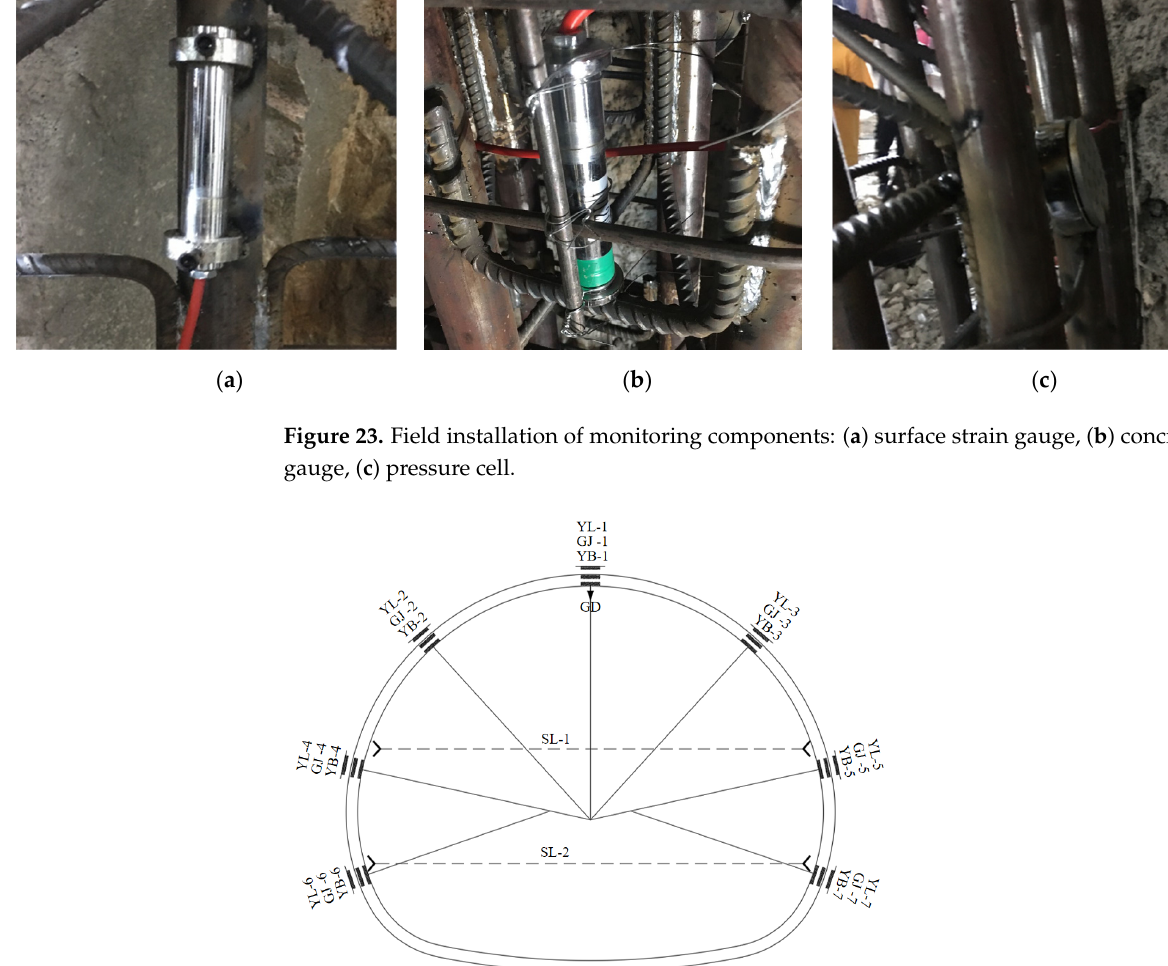
Figure 24. Diagram of monitoring component setup.